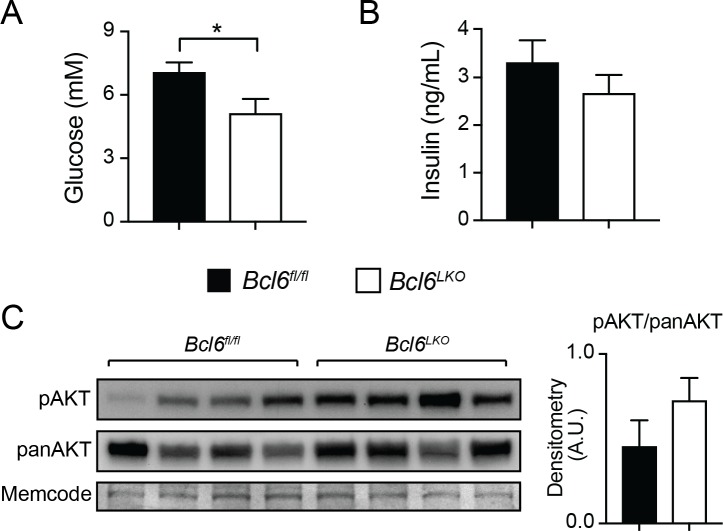
Mice lacking hepatic Bcl6 have improved insulin sensitivity after high-fat diet.(A–B) Overnight fasted serum (A) glucose and (B) insulin in Bcl6fl/fl and Bcl6LKO mice after 17 weeks of high-fat diet. N = 6–9 per group. (C) Western blots showing phosphorylated AKT (pAKT) and total AKT (panAKT) protein levels following injection of insulin in Bcl6fl/fl and Bcl6LKO livers. MemCode membrane staining is used as the loading control. Densitometric analysis shows ratio of pAKT over panAKT (right). Data are represented as mean ±SEM. ∗p<0.05, ∗∗p<0.01, ∗∗∗p<0.001.